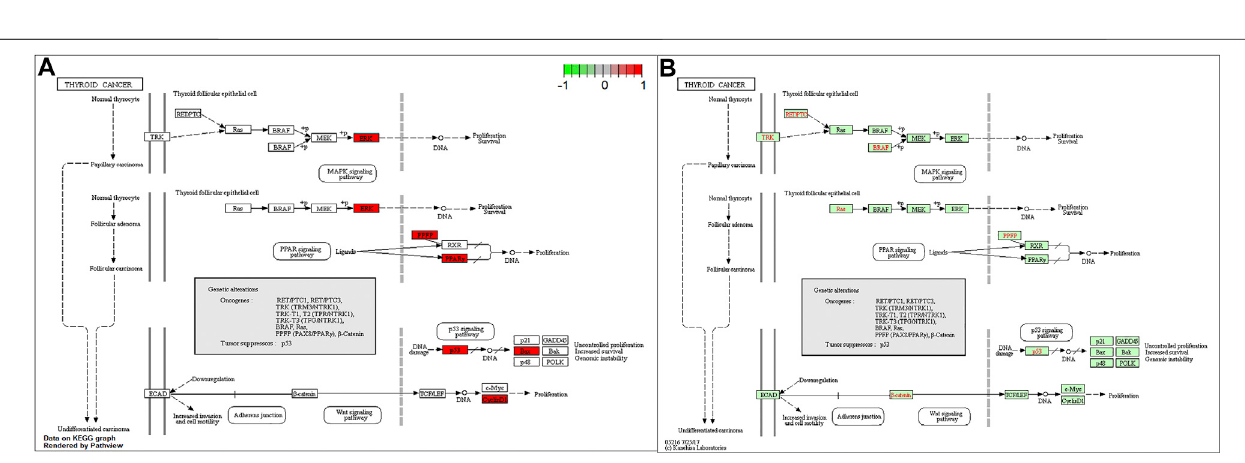
FIGURE 6 | The KEGG signaling